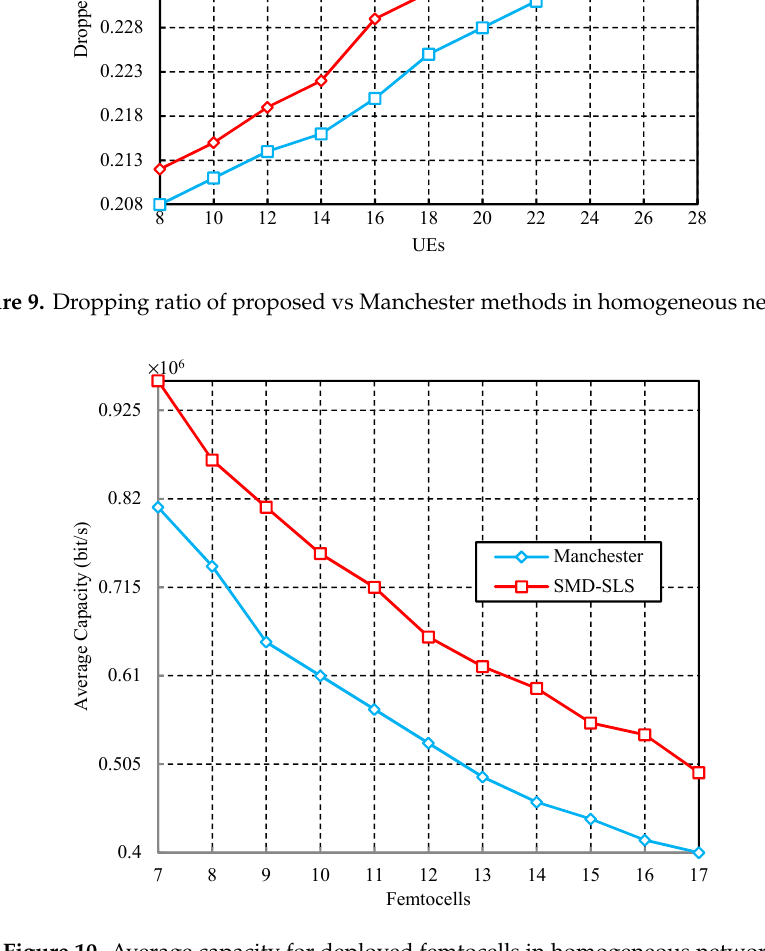
Figure 10. Average capacity for deployed femtocells in homogeneous network.